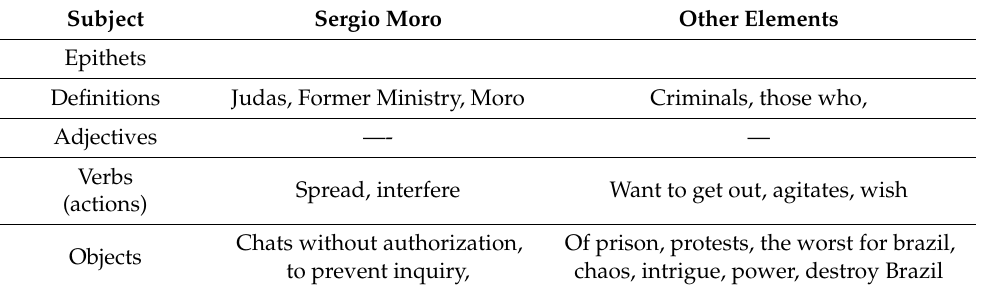
Table 23. Sergio Moro and other